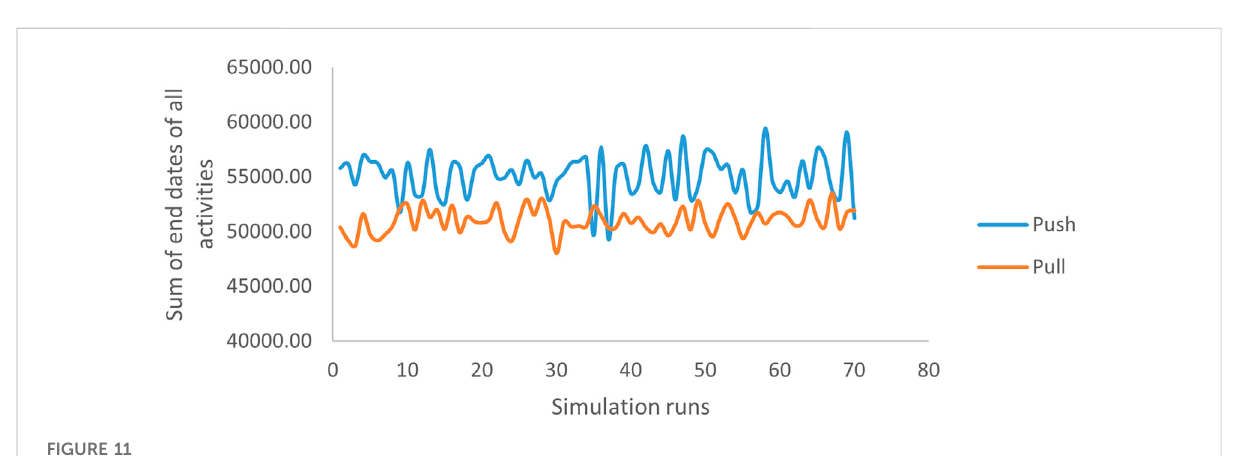
FIGURE 11 Sum of activities ’ end